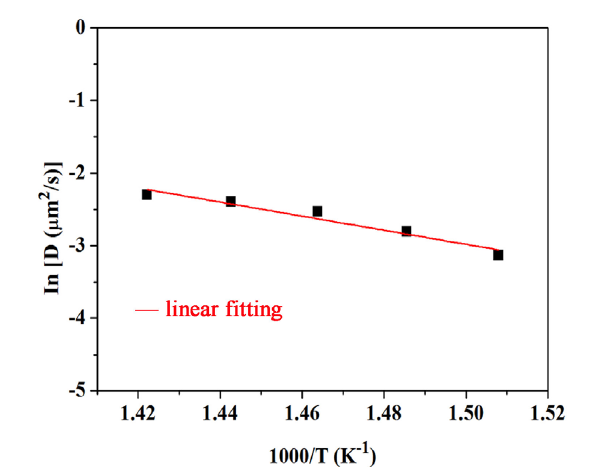
FigUre 2 | Diffusion coefficient as a function of reciprocal temperature for ion-exchanged x P 2 O 5 –(100 − x )(0.25na 2 O–0.08al 2 O 3 – 0.67siO 2 ) ( x = 5) glass at different ion-exchange temperatures for 6 h .